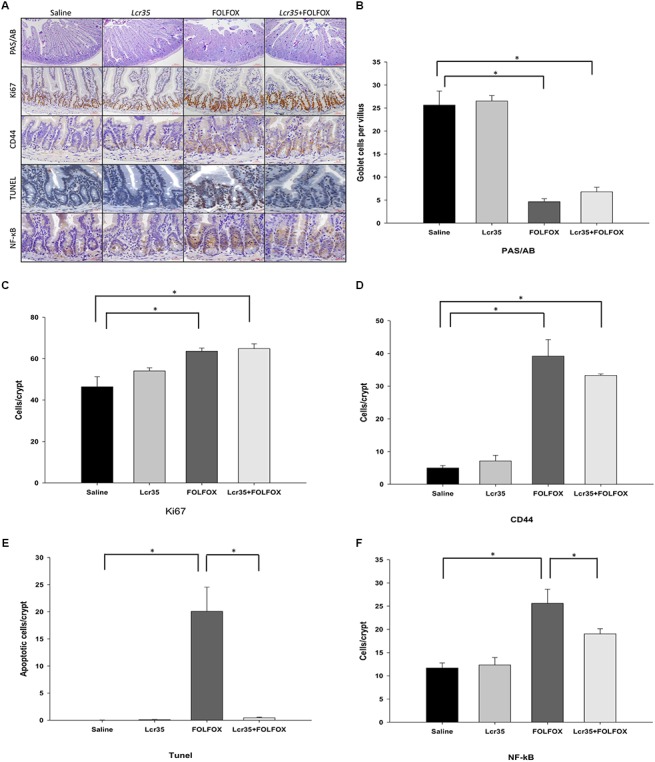
Effects of Lcr35 on goblet cells, proliferation, regeneration, apoptosis, and NF-κB activity in FOLFOX-induced intestinal damage in subcutaneously injected colorectal carcinoma mice. (A) Immunohistochemical staining of jejunum sections was used to determine Lcr35 effects on PAS (dark purple)/AB staining (goblet cells), Ki67 (brown) expression to detect proliferative activity, CD44 (brown) staining to detect regeneration activity, TUNEL (brown) to detect DNA breaks, and NF-κB activity (brown) in the intestine using antibodies. Quantification of the staining intensity of (B) PAS/AB in the intestinal villus, (C) Ki67, (D) CD44, (E) TUNEL, and (F) NF-κB in the intestinal crypt in (A). Scale bar = 100 μm. The mice received saline or Lcr35 (1 × 107 CFU/daily) daily during the experiment. Results are representative of four individual experiments and are presented as the mean ± SEM. ∗p < 0.05.